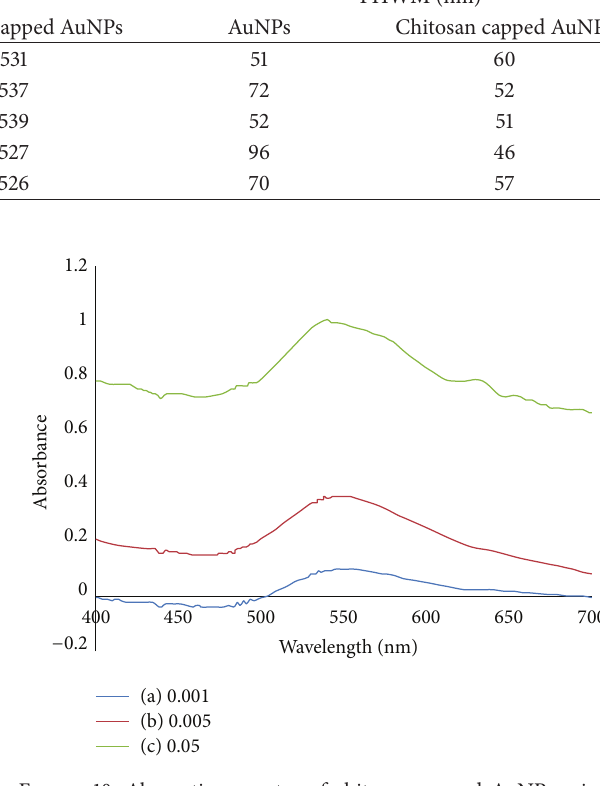
Figure 10: Absorption spectra of chitosan capped AuNPs mixed with different weights of 𝛼 -CNTs: (a) 0.001 g; (b) 0.005 g; (c) 0.05 g. and hinders agglomeration of AuNPs. The FWHM and other experimental results are listed in Table